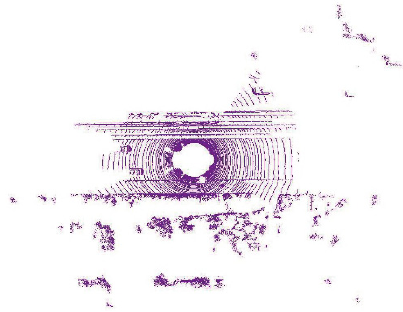
Figure 5. Point cloud data before filtering.